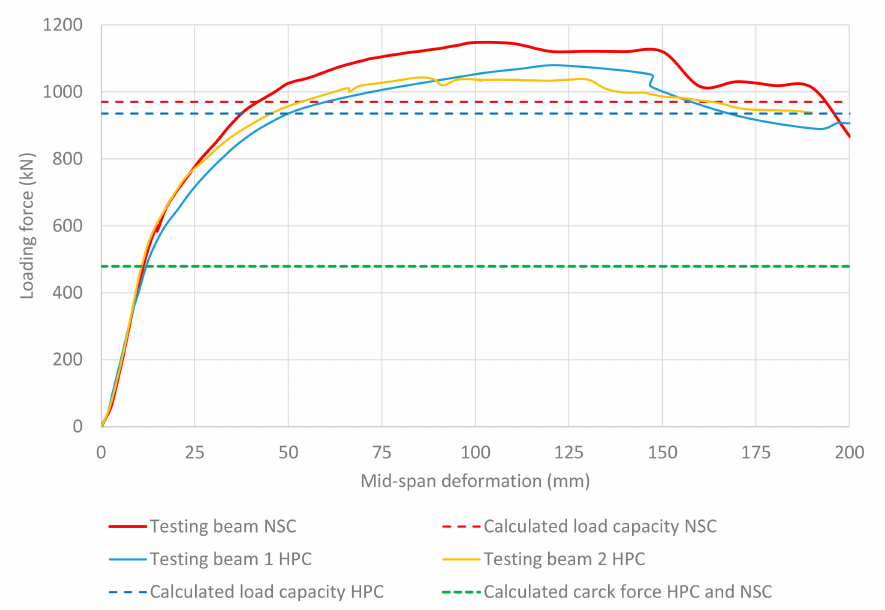
Figure 9. Load–deformation diagram testing of NSC beam compared with testing of HPC beams.